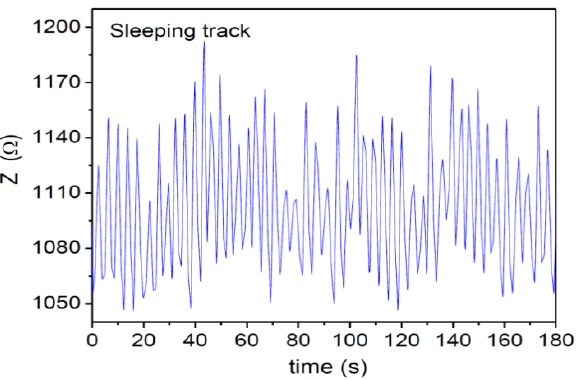
Figure 6. Breathing pattern of Subject 2 (36 YO) during 180 s of sleep and periodic sleeping patterns were observed.